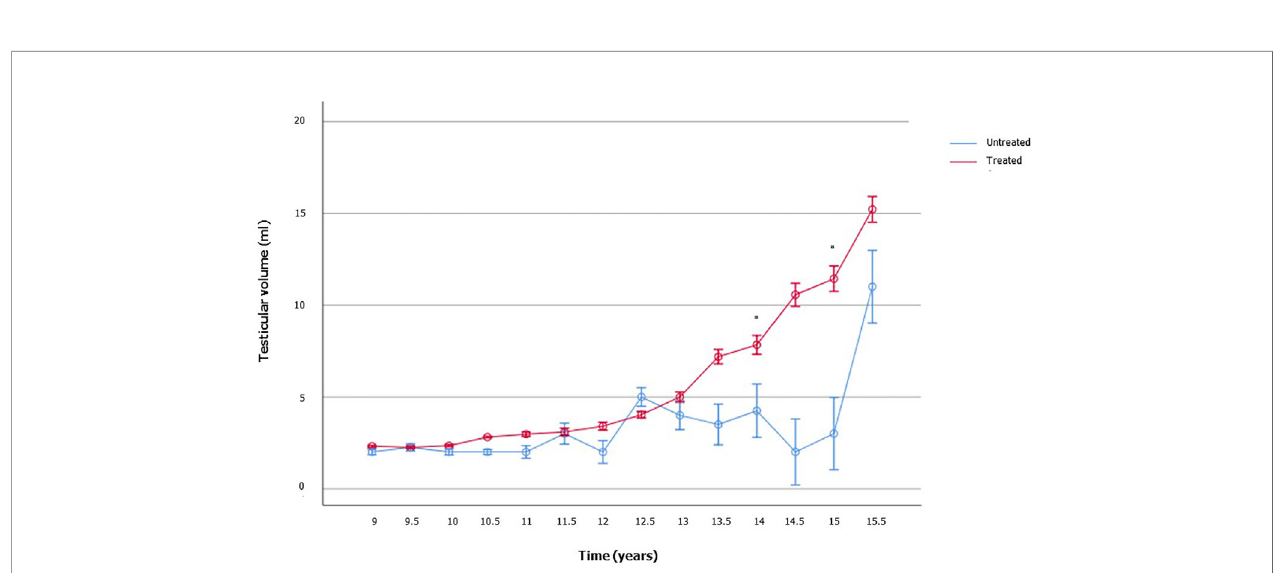
FIGURE 2 | Testicular volume changes over time in boys with growth hormone (GH) de fi ciency who received recombinant human GH (rhGH) and in aged-matched not yet treated GHD boys. The number of patients available for each time point is reported in the Supplementary Table 1